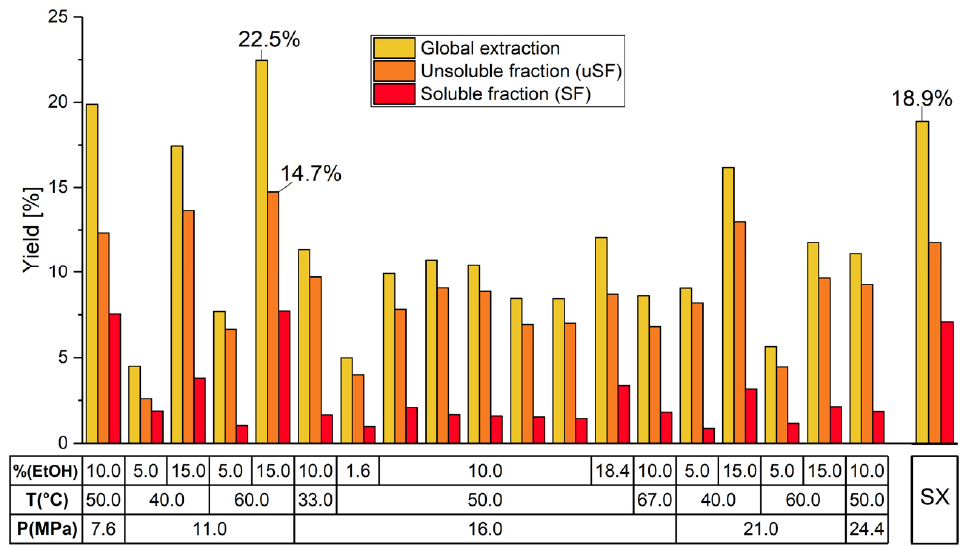
Figure 1. Extraction yield under the supercritical CO 2 + EtOH and Soxhlet (SX) extraction methods.